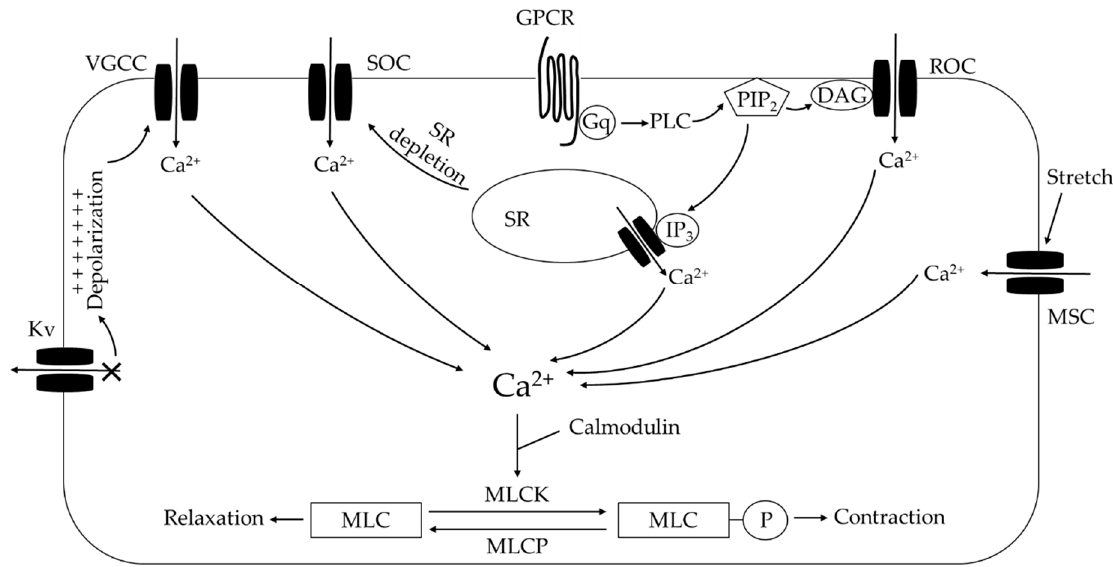
Figure 4. Summary of Ca 2 + -dependent influx and release mechanisms in pulmonary arterial smooth muscle cells following chronic hypoxia. See text for details. K V , voltage-gated K + channel; VGCC, voltage-gated Ca 2 + channel; SOC, store-operated channel; ROC, receptor-operated channel; MSC, mechanosensitive channel; GPCR, G protein-coupled receptor; PLC, phospholipase C; PIP 2 , phosphatidylinositol 4,5-bisphosphate; DAG, diacylglycerol; IP 3 , inositol triphosphate; SR, sarcoplasmic reticulum; MLCK, myosin light chain kinase; MLCP, myosin light chain phosphatase; MLC, myosin light